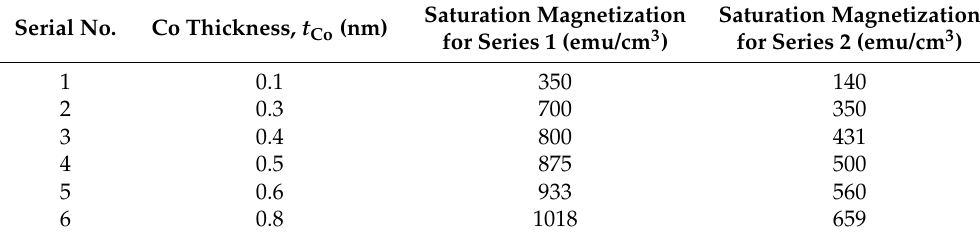
/Pd 0.9 ) × 10 ] samples Co /Pd 0.9 ) ×10 ] samples t Co